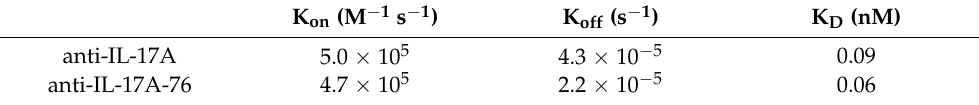
Table 1. Kinetic analysis of interactions of IL-17A with V H H domain